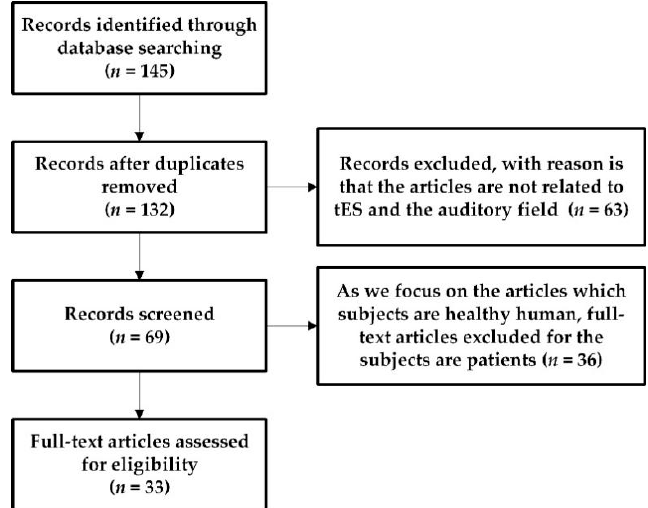
Figure 1. A flowchart presenting the study inclusion/exclusion criteria. We investigated a total of 145 articles in the database, excluding 13 duplicate articles. Further rough screening excluded 63 articles that the articles are not related to transcranial electrical stimulation (tES) and the auditory field. Finally, 33 articles were selected for review.